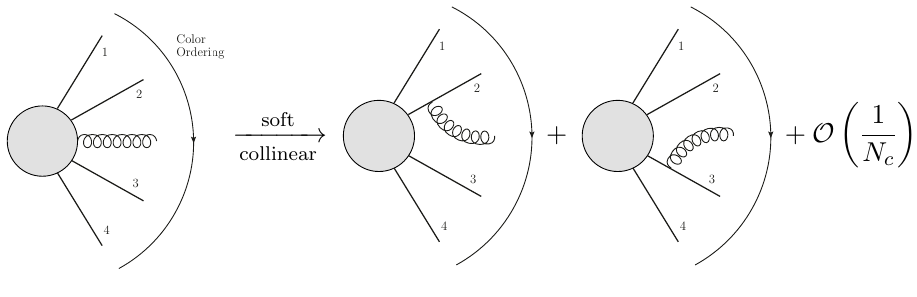
Figure 1 . Factorization of soft or collinear gluon emission in leading-color